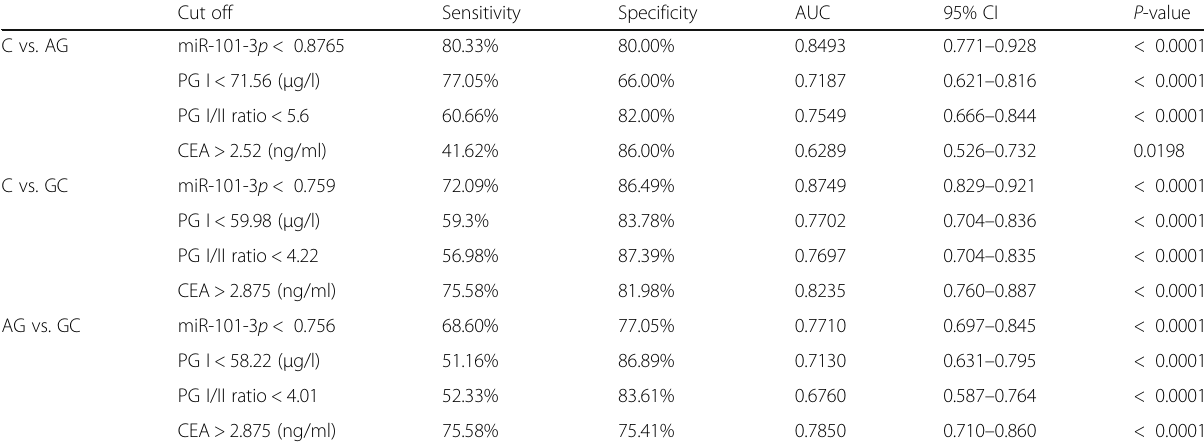
Table 3 The diagnostic value of serum marker alone on atrophic gastritis (AG) and gastric cancer (GC) Cut off